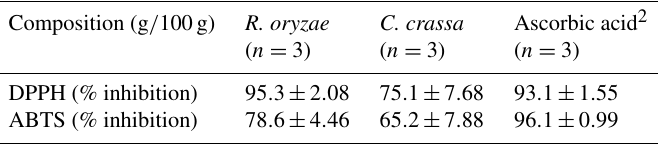
Table 1. Percentage inhibition values of the fungi towards DPPH or ABTS free radicals 1 .